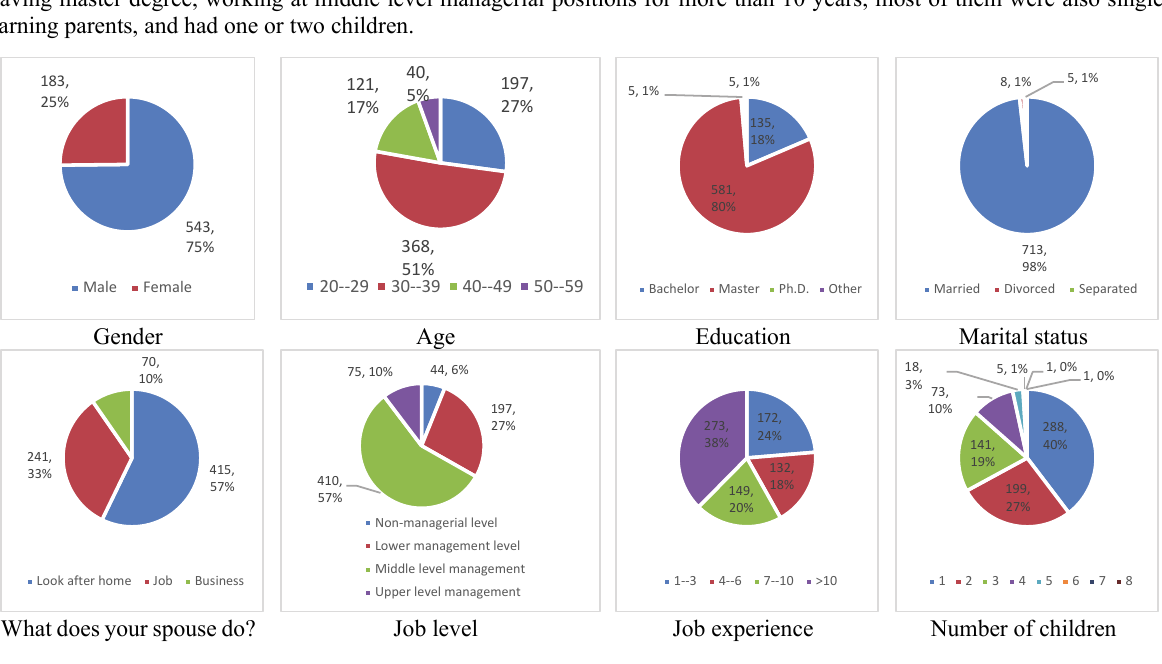
Fig. 2. Demographic